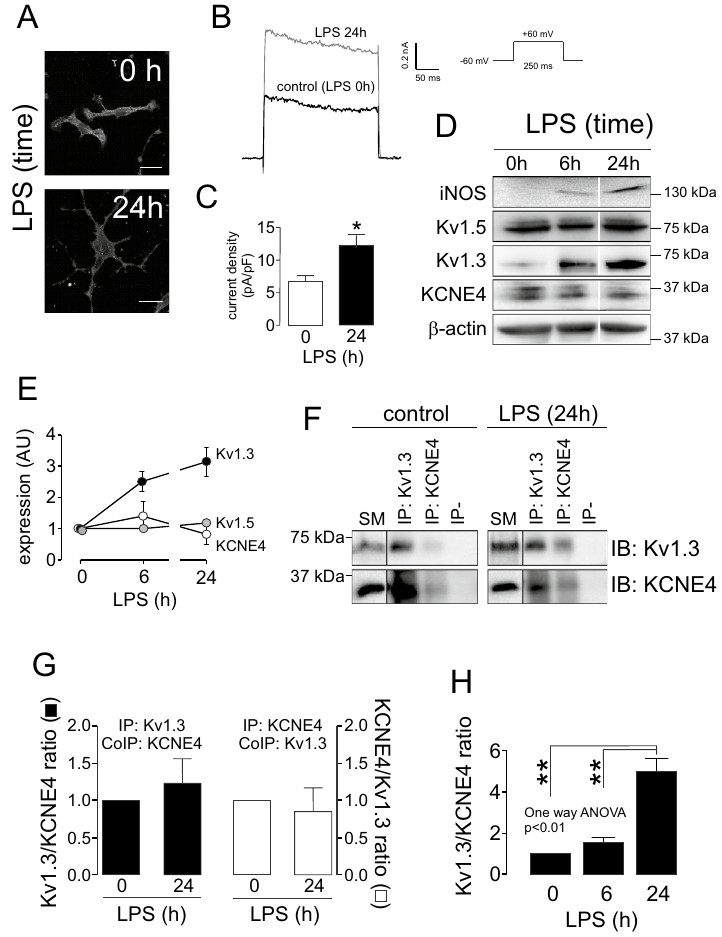
Figure 6. LPS-dependent activation increases the Kv1.3/KCNE4 ratio in CY15 dendritic cells. Cells were treated for 24 h with LPS (100 ng/ml), and the protein expression of selected K + channel proteins was studied at 0, 6 and 24 h. ( A ) Confocal images of CY15 cells stained with Kv1.3 upon LPS treatment. Scale bars: 20 µm. ( B ) Representative voltage-dependent K+ currents elicited in CY15 cells treated with (LPS 24 h) or without (LPS 0 h) LPS during 24 h. Cells were held at -60 mV and 250 ms pulses to +60 mV were applied. ( C ) Peak current densitiy (pA/pF) of K + currents from CY15 cells in the absence (0 h) or the presence (24 h) of LPS. White bars, LPS 0 h (control); black bars, LPS 24 h. Values are the mean ± SE of 4–6 cells. *p < 0.05 vs 0 h, Student’s t test. ( D ) Representative western blot of Kv1.5, Kv1.3 and KCNE4. The expression of iNOS monitored cellular activation in the presence of LPS. β-actin was used as a loading control. Representative cropped blots, clearly delineated by vertical white lines, are shown. ( E ) Relative expression of protein abundance. Kv1.3, black circles; Kv1.5, gray circles; KCNE4, white circles. ( F ) Coimmunoprecipitation of Kv1.3 and KCNE4 in CY15 cells in the absence (control) or presence of LPS for 24 h. Lysates were immunoprecipitated against Kv1.3 (IP: Kv1.3) and KCNE4 (IP: KCNE4) and immunoblotted (IB) against Kv1.3 and KCNE4. Upper panel: Kv1.3. Lower panel: KCNE4. SM: starting material. IP−: Immunoprecipitated in absence of antibodies. Representative cropped blots from SM, clearly delineated by vertical black lines, are shown. (G) Relative coimmunoprecipitation of KCNE4 with Kv1.3 (Kv1.3/KCNE4 ratio) and Kv1.3 with KCNE4 (KCNE4/Kv1.3 ratio). Black bars, Kv1.3 was immunoprecipitated (IP: Kv1.3), and the associated KCNE4 (CoIP: KCNE4) was analyzed. White bars, KCNE4 was immunoprecipitated (IP: KCNE4), and the association of Kv1.3 (CoIP: Kv1.3) was analyzed. (H) The Kv1.3/ KCNE4 ratio calculated from the protein expression of Kv1.3 and KCNE4 in LPS-treated CY15 dendritic cells. Values are mean ± SE of n = 4 independent samples. **p < 0.01 One-way ANOVA with post hoc Tukey’s